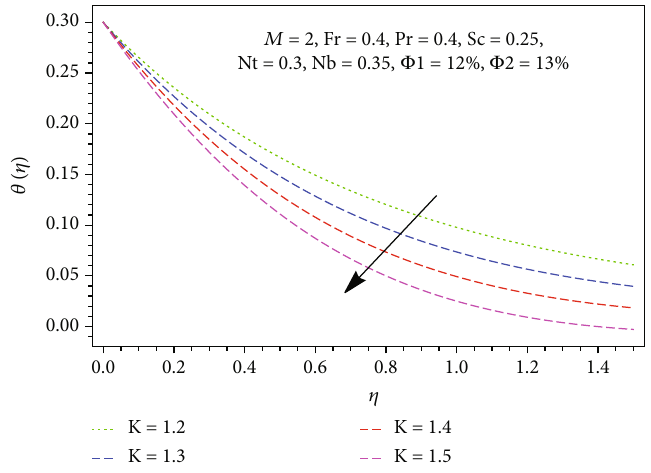
Figure 15: Impact of couple stress parameter K on the energy pro fi le θ ð η Þ .